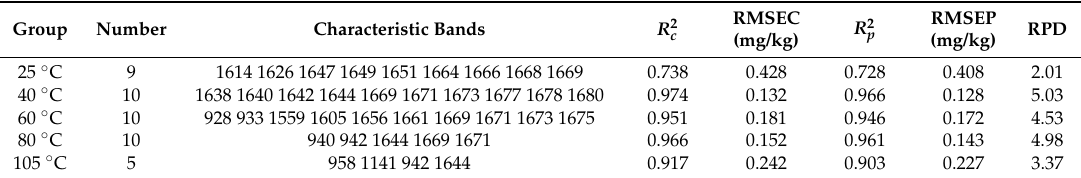
Table 4. The characteristic variables and prediction effects of CARS-BIPLS-PLS.